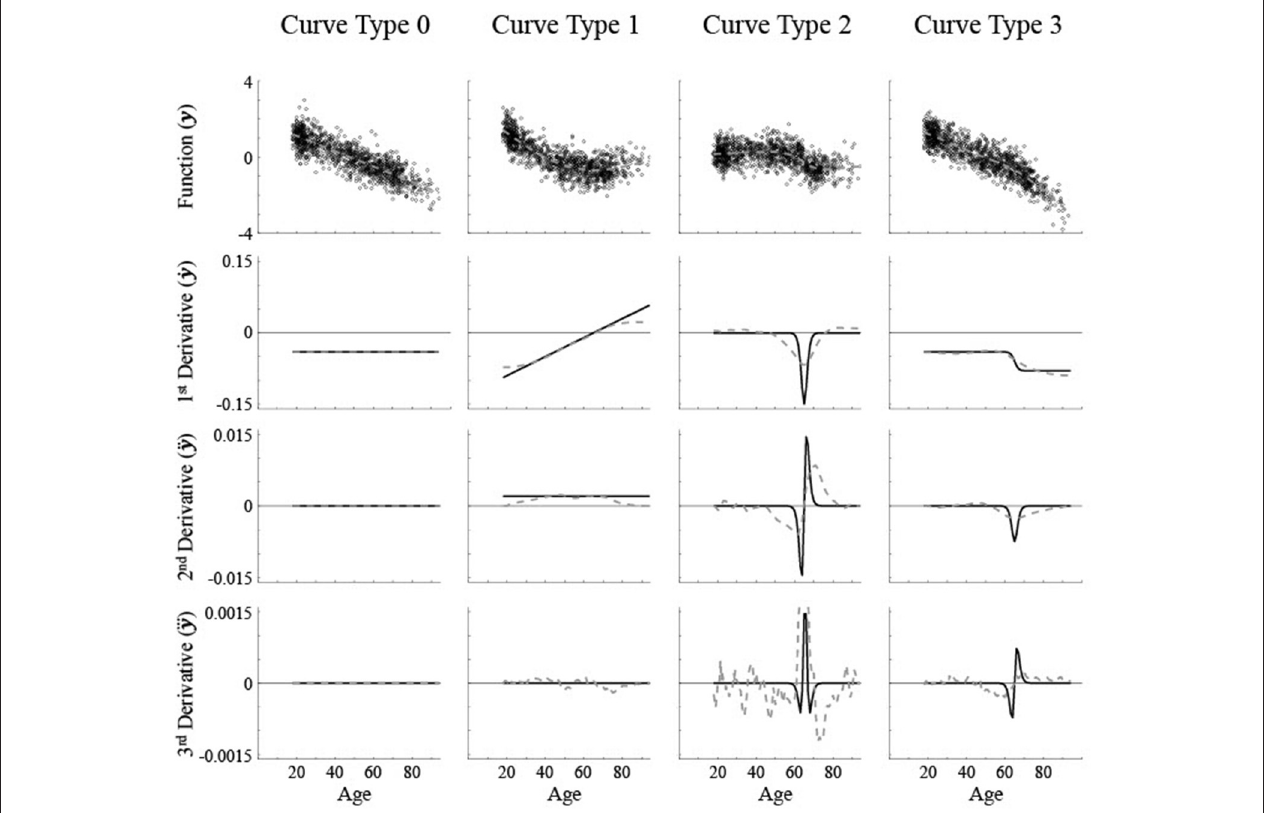
FIGURE 1 | Simulated data along with the first three derivatives of the best fit smoothing spline (gray dashed lines). The actual curve (black solid line) that the simulated data is based on is shown in the first derivative row. A medium level of noise ( σ 0.5) was used. The critical age for all non-linear curves is 65. Curve Type 0 = has a constant first derivative, aka maturation rate, with no critical age. Curve Type 1 has a linear maturation rate with a critical age at the 1st derivative zero point. Curve Type 2 has a Gaussian maturation rate with a critical age at a 2nd derivative zero point. Curve Type 3 has a sigmoidal maturation rate with a critical age at a 3rd derivative zero